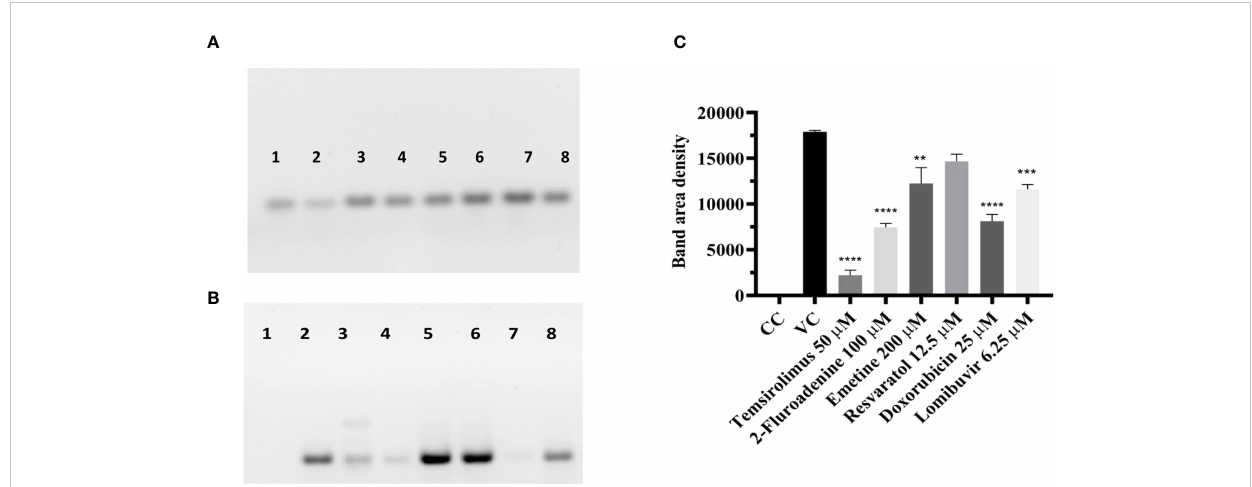
FIGURE 7 Effect of different drugs on CHIKV infection under posttreatment condition using western blot (A) b -actin expression in the cell lysates. (B) Antigens probed with the anti-CHIKV MAb. The MAb speci fi cally detected the C protein of CHIKV expression which was normalized using the reference loading control b -actin, western blot image comparing the uninfected cells, infected cells (posttreatment with different drugs (C) . Bar plot of the intensities of capsid determined via ImageJ analysis from supernatants of treated and untreated cells (mean + SD, n=3 replicates). CHIKV antigen probed with a cell lysate of CHIKV-infected Vero cells shows the high-density band in lane-2. 2-Fluroadenine, temsirolimus and doxorubicin showed a signi fi cant reduction of C protein levels **p<0.01, ***p<0.001, ****p<0.0001 respectively (Lane-2,3,7). CHIKV antigen probed with lysate from emetine, resveratrol and lomibuvir, treated cells showing bands of 30-35kDa corresponding to the C protein of CHIKV (Lane-4,5,6,8) respectively. CHIKV antigen probed with cell control (uninfected cells), showing no reaction